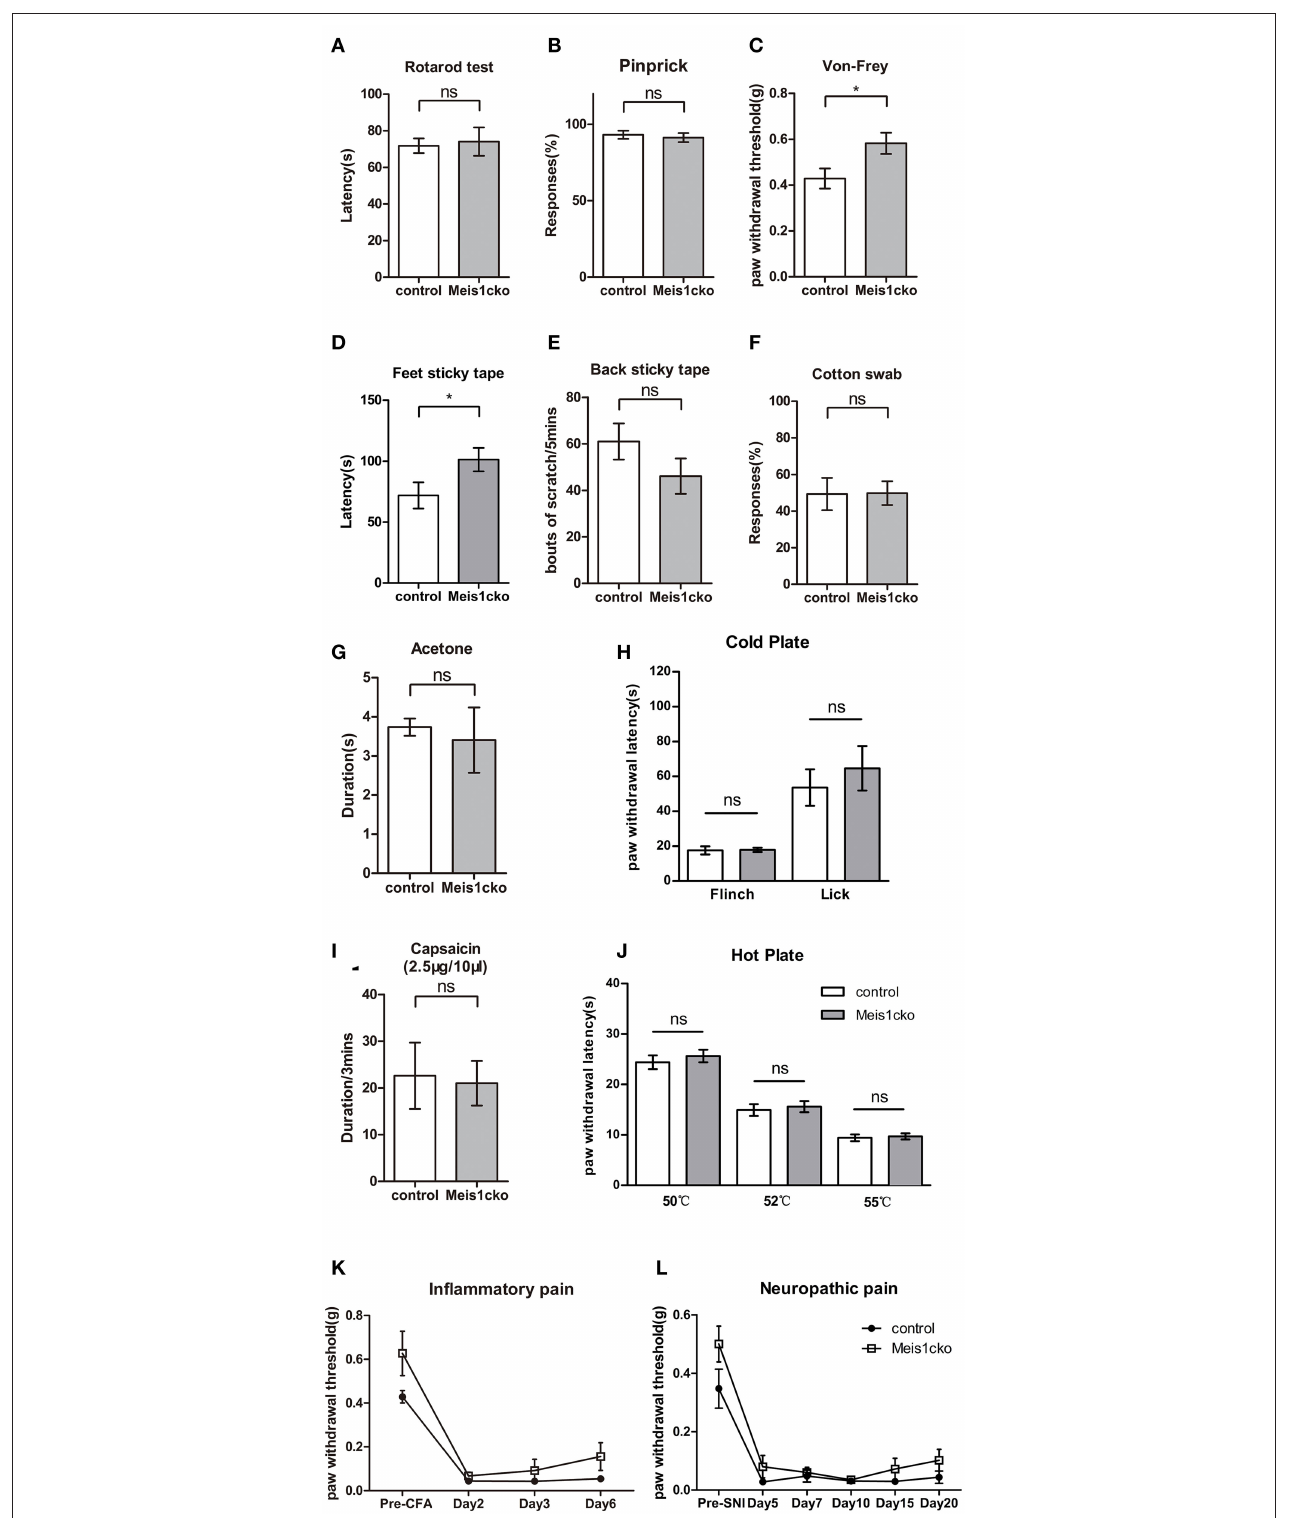
FIGURE 5 | Attenuated response to static touch and light mechanical pain in Meis1cko mice. (A) The rotarod assay. Control and Meis1cko mice showed identical latencies to fall off the rotarod ( n = 5 control mice, n = 4 Meis1cko mice; p > 0.05). (B) Acute mechanical pain assessed using the pinprick test. Control